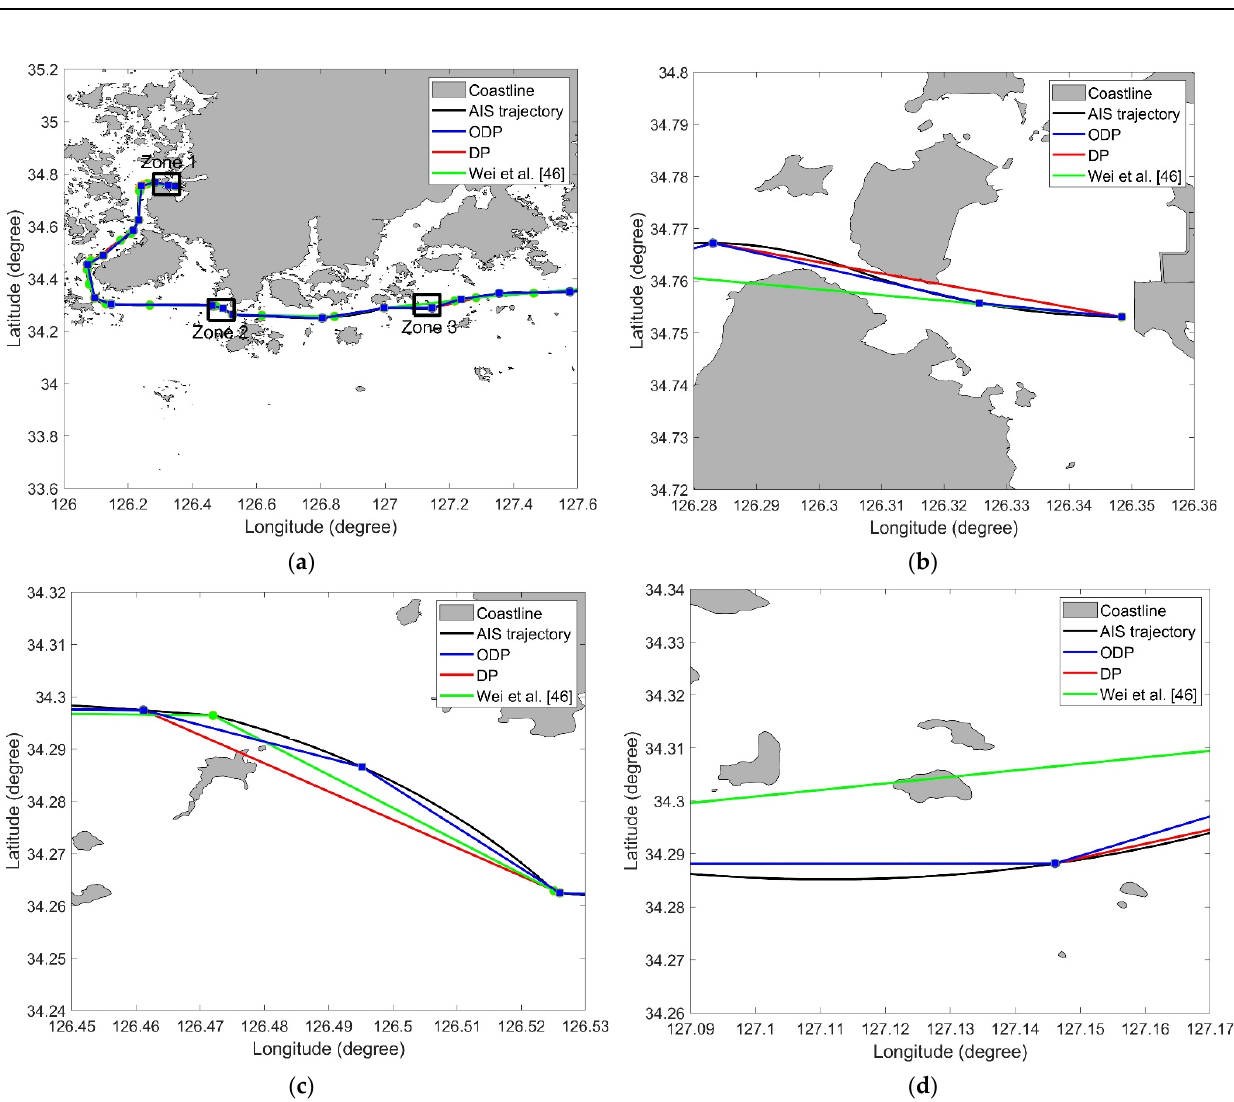
Figure 11. Results obtained from the ODP and DP algorithms for trajectory 2 ( 𝜖 = 1.0 ): ( a ) Overview; ( b ) Zone 1 in ( a ); ( c ) Zone 2 in ( a ); ( d ) Zone 3 in ( a ) [46].